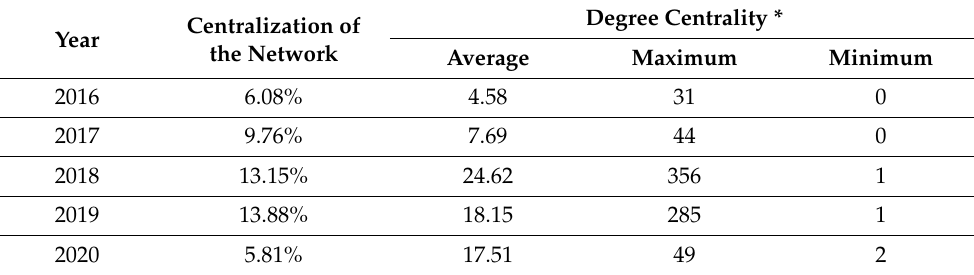
Table 6. The centrality of the food safety risk transfer network.